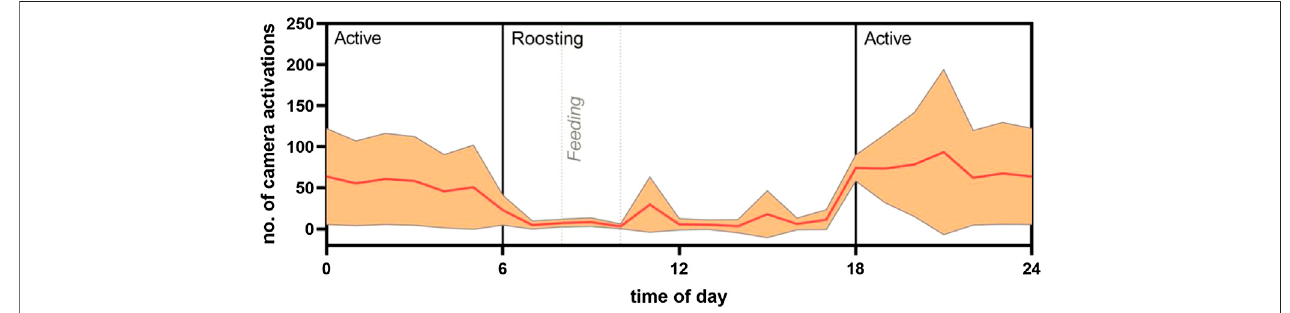
FIGURE3 | Proxy ofcircadian activity from frequency ofcamera activation. The mean number ofcameraactivations in an aviary of 30individualsof R.aegyptiacus bats was analyzed in association to the time of day. Camera activation is displayed in relation to active/roosting phases of the bats. Light regime: 6:00 lights on; 18:00 lights off (both with dimming effect). Orange line represents the mean, ±SD displayed as shading.